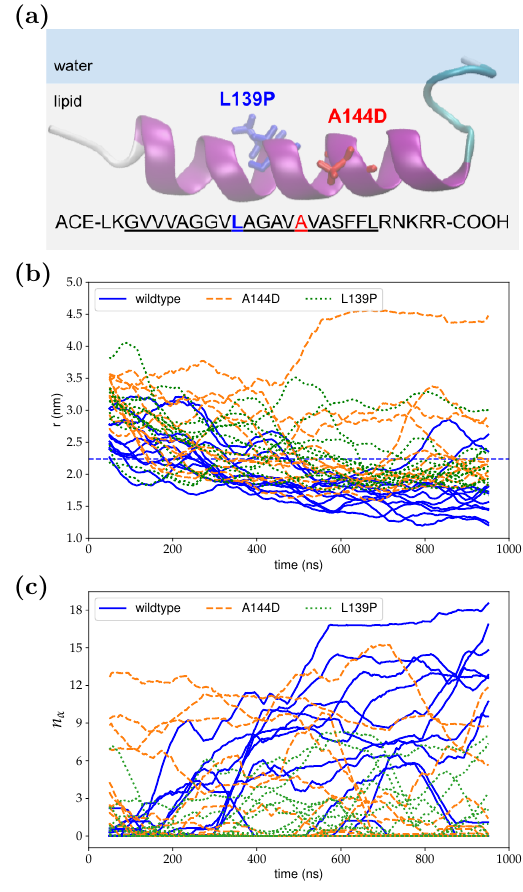
Figure 2. Comparison of the wild-type Fis1(TA), A144D and L139P mutations via eleven separate SA runs for each. ( a ) Graphical representation of the molecules; ( b ) the orthogonal distance from the peptide center-of-mass to the membrane center line; ( c ) the number of residues in α -helix conformation. Wild-type Fis1(TA), A144D, and L139P results are shown with solid blue, dashed orange and dotted green lines,